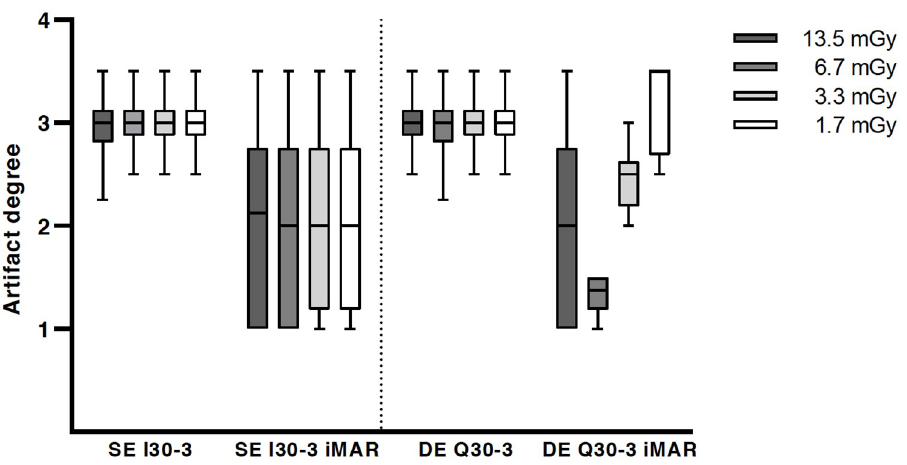
Fig 6. Qualitative analysis of artifact degree with significant metal artifact reduction for iMAR.